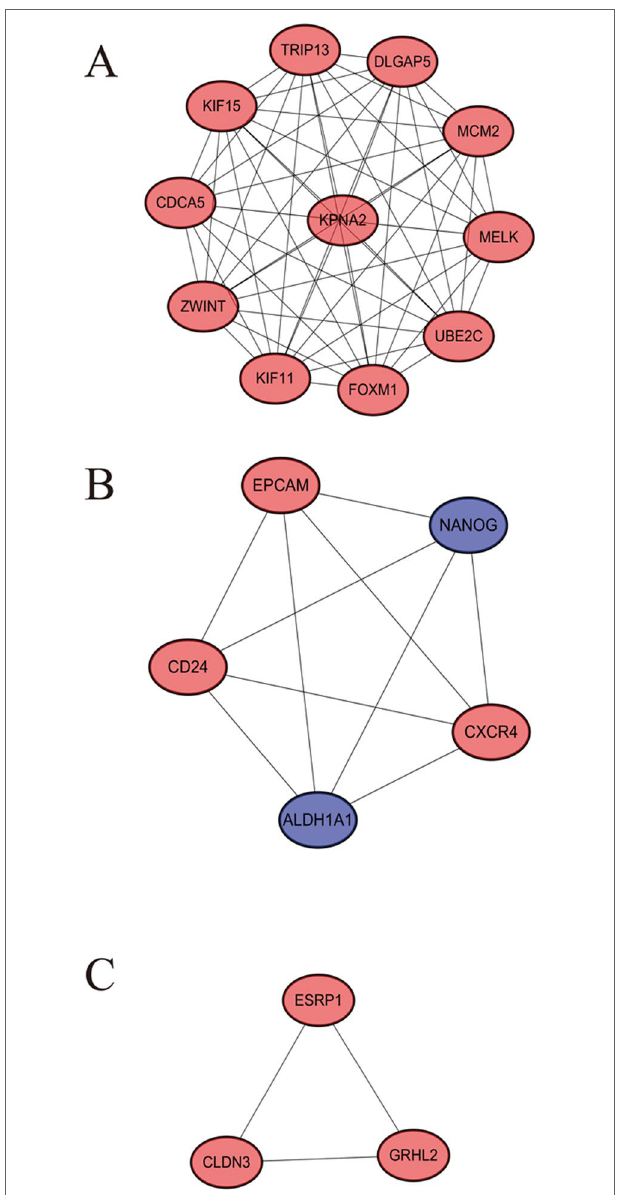
FIgUrE 6 | A significant module selected from protein–protein interaction network. (A) Cluster 1, (B) cluster 2, (C) cluster 3.